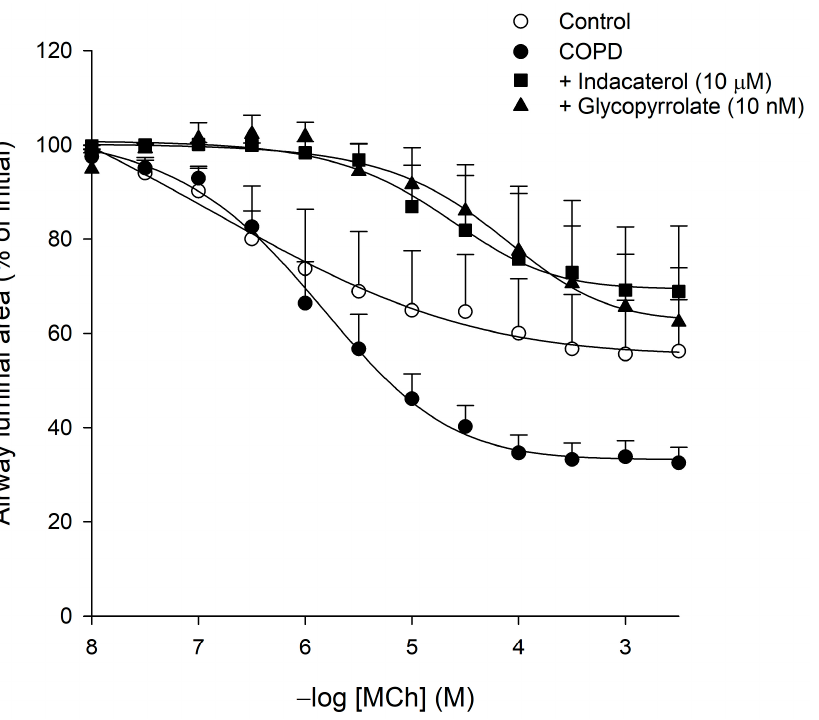
Figure 3. Methacholine (MCh)-induced constriction of small intrapulmonary airways (<500 μ m) in human lung slices obtained from COPD GOLD I and II patients and non-COPD controls. The effects of the β 2 -agonist indacaterol (10 µ M) and the anticholinergic glycopyrrolate (10 nM) on methacholine-induced airway constrictions ere determined in lung slices obtained from COPD patients. Airway constriction was determined by measuring the luminal area as a percentage of baseline. Data are represented as means ± SEM of 3–7 subjects (see also Table 3). Table 3. Effects of indacaterol and glycopyrrolate on methacholine-induced airway constriction of human intrapulmonary airways obtained from non-COPD control subjects and COPD patients (GOLD I and II).